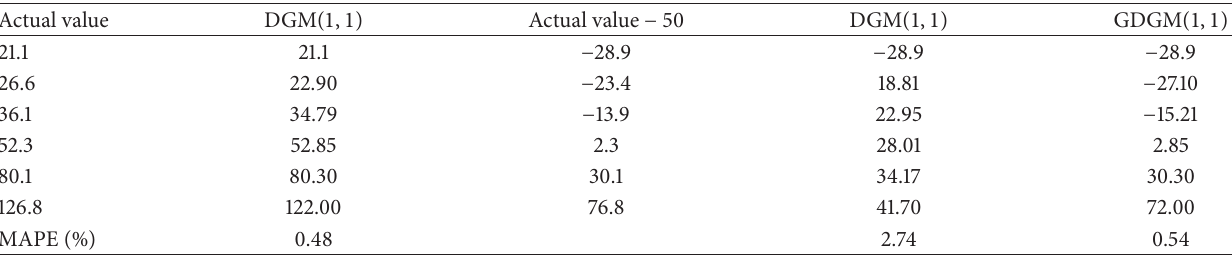
Table 3: Simulation by DGM( 1,1 ) and GDGM( 1, 1